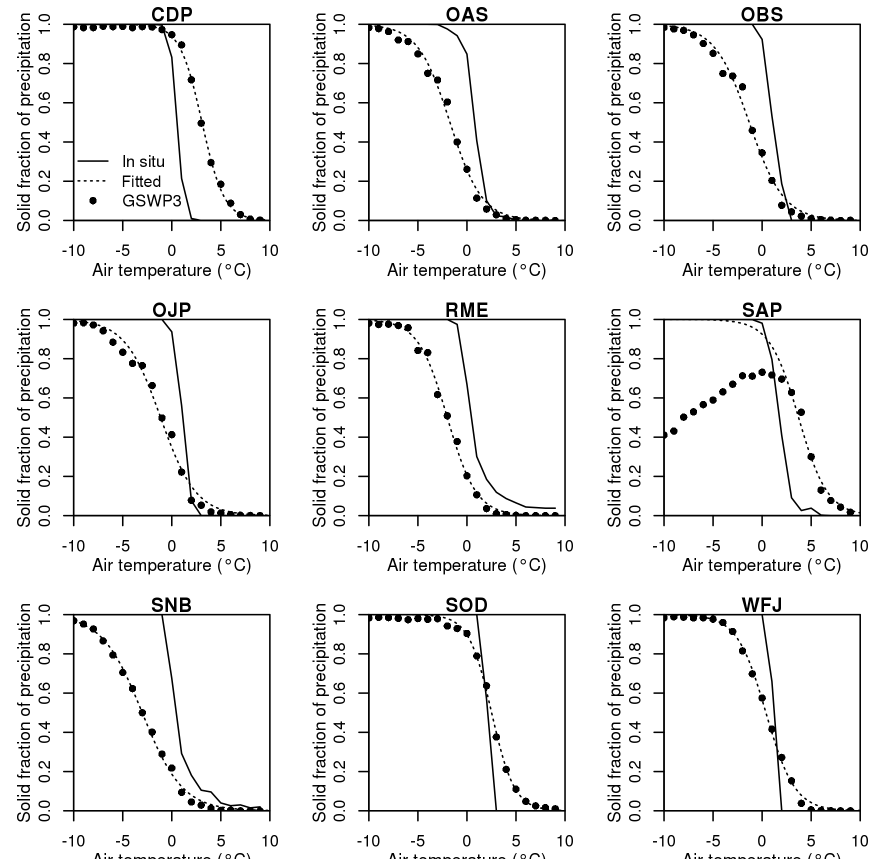
Figure 3. Example scatter plots of relative humidity against temperature for four of the sites. The solid lines show ice saturation at tempera- tures below 0 ◦ C and water saturation above. Lines of constant specific humidity near the upper end of the